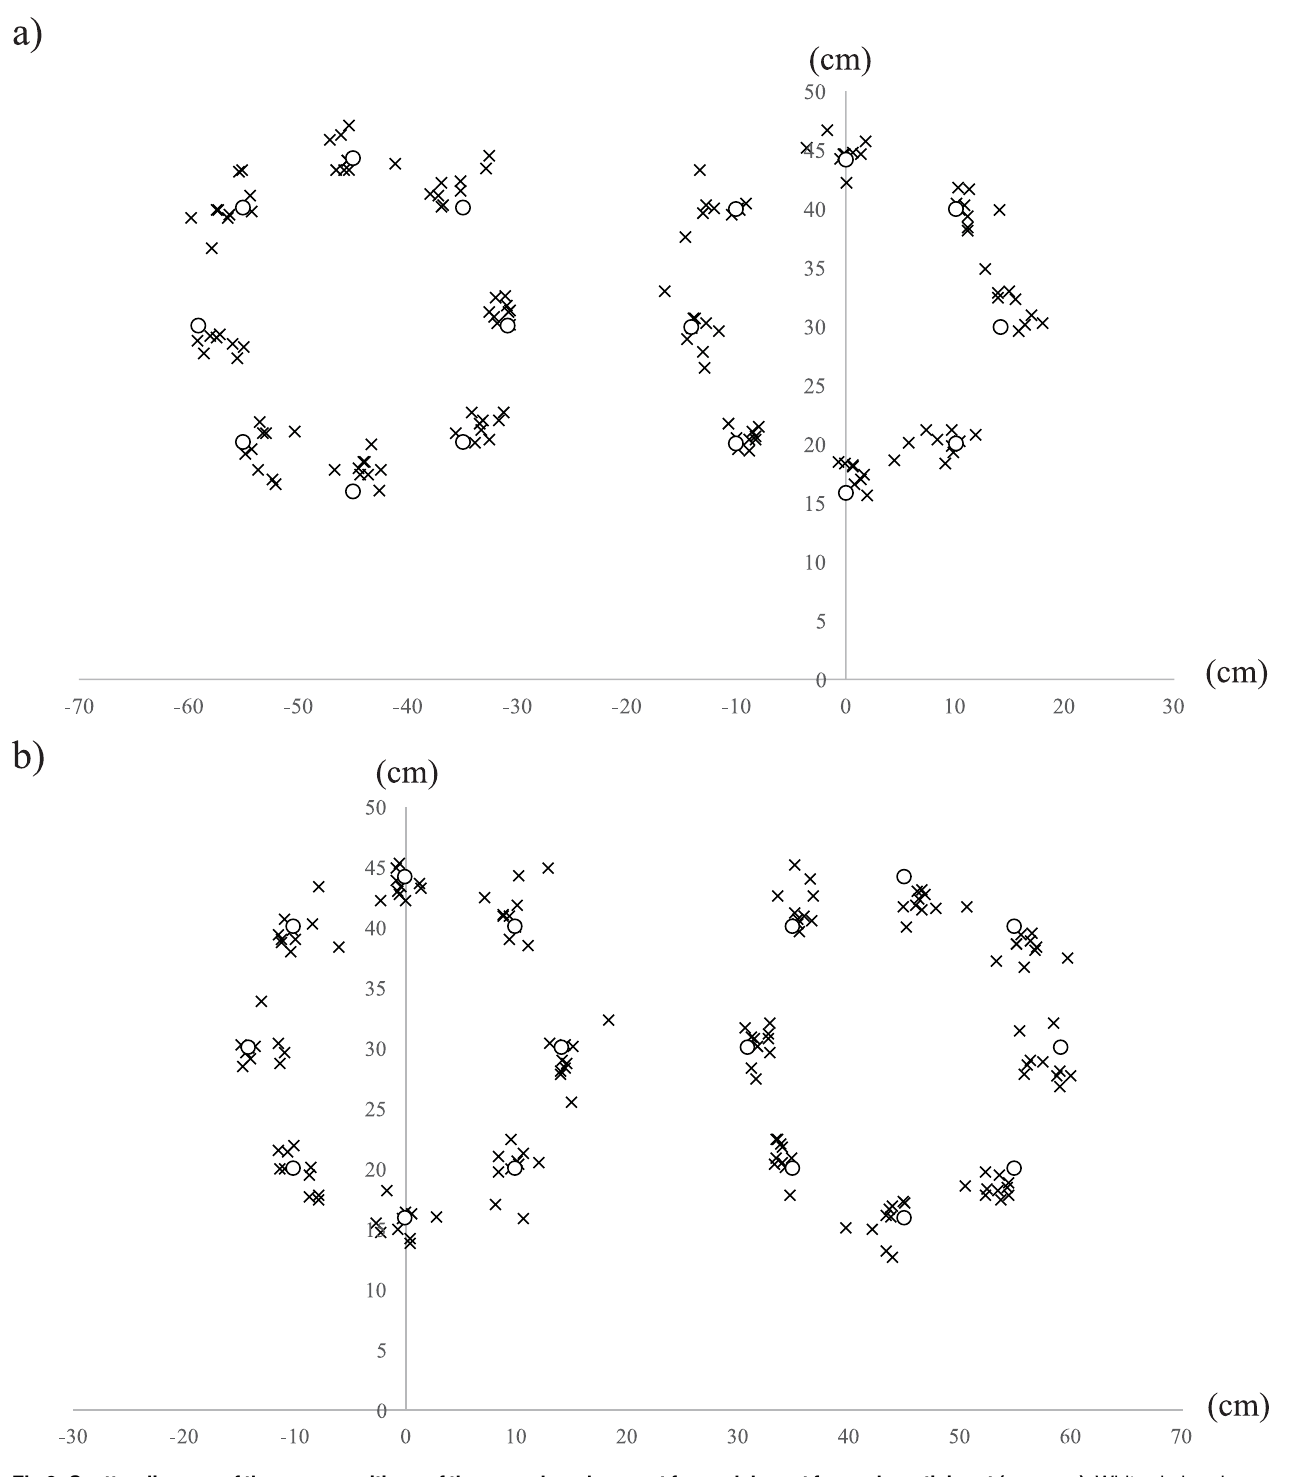
PLOS ONE | DOI:10.1371/journal.pone.0160095 July 27,